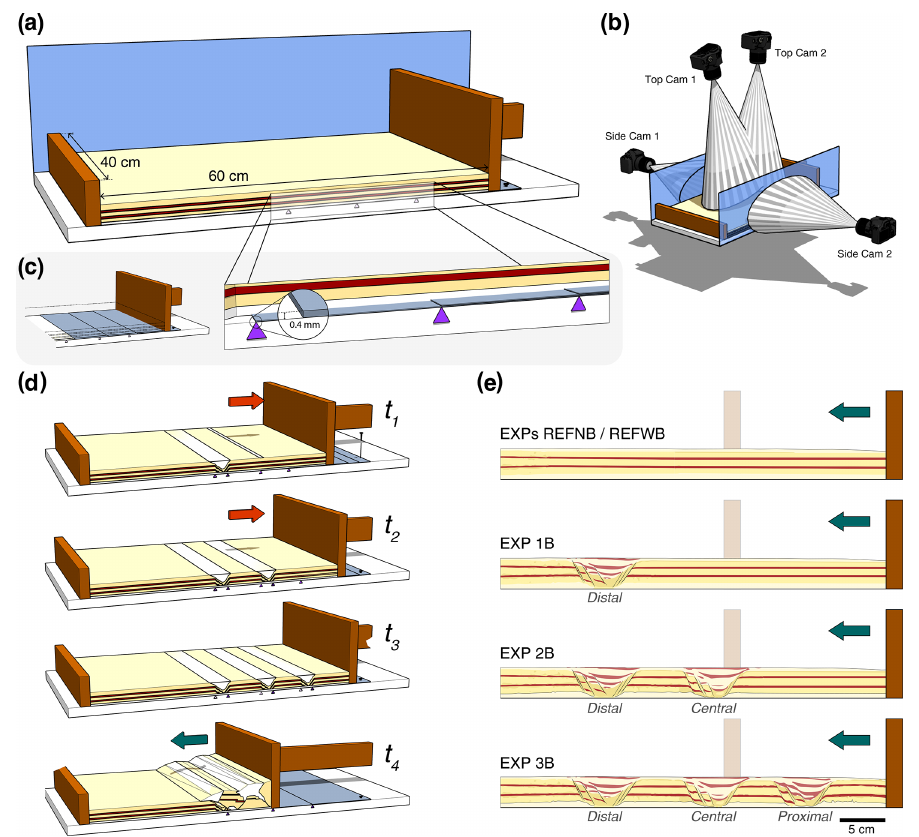
Figure 2. Modelling set-up. (a) Sketch of the employed apparatus, oblique view. (b) Sketch showing the overall camera set-up for PIV processing. (c) Close-up view of the basal sheet system. Triangles indicate the end of each sheet. (d) Illustrated example showing the steps involved in the basin formation – extension – and basin inversion – shortening – stages of the experiments. (e) Summary of initial conditions for the shortening